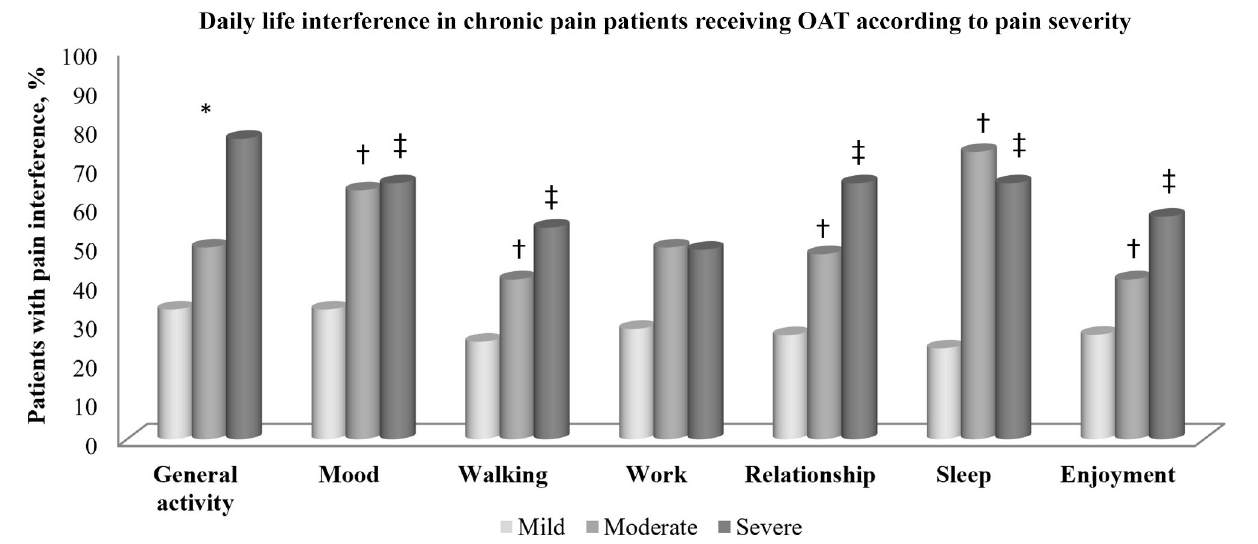
FIGURE 1 | Daily life interference in chronic pain patients according to pain severity. *All groups different, p < 0.01. † Difference between moderate pain vs. mild pain; p < 0.01. ‡ Difference between severe pain vs. mild pain; p <